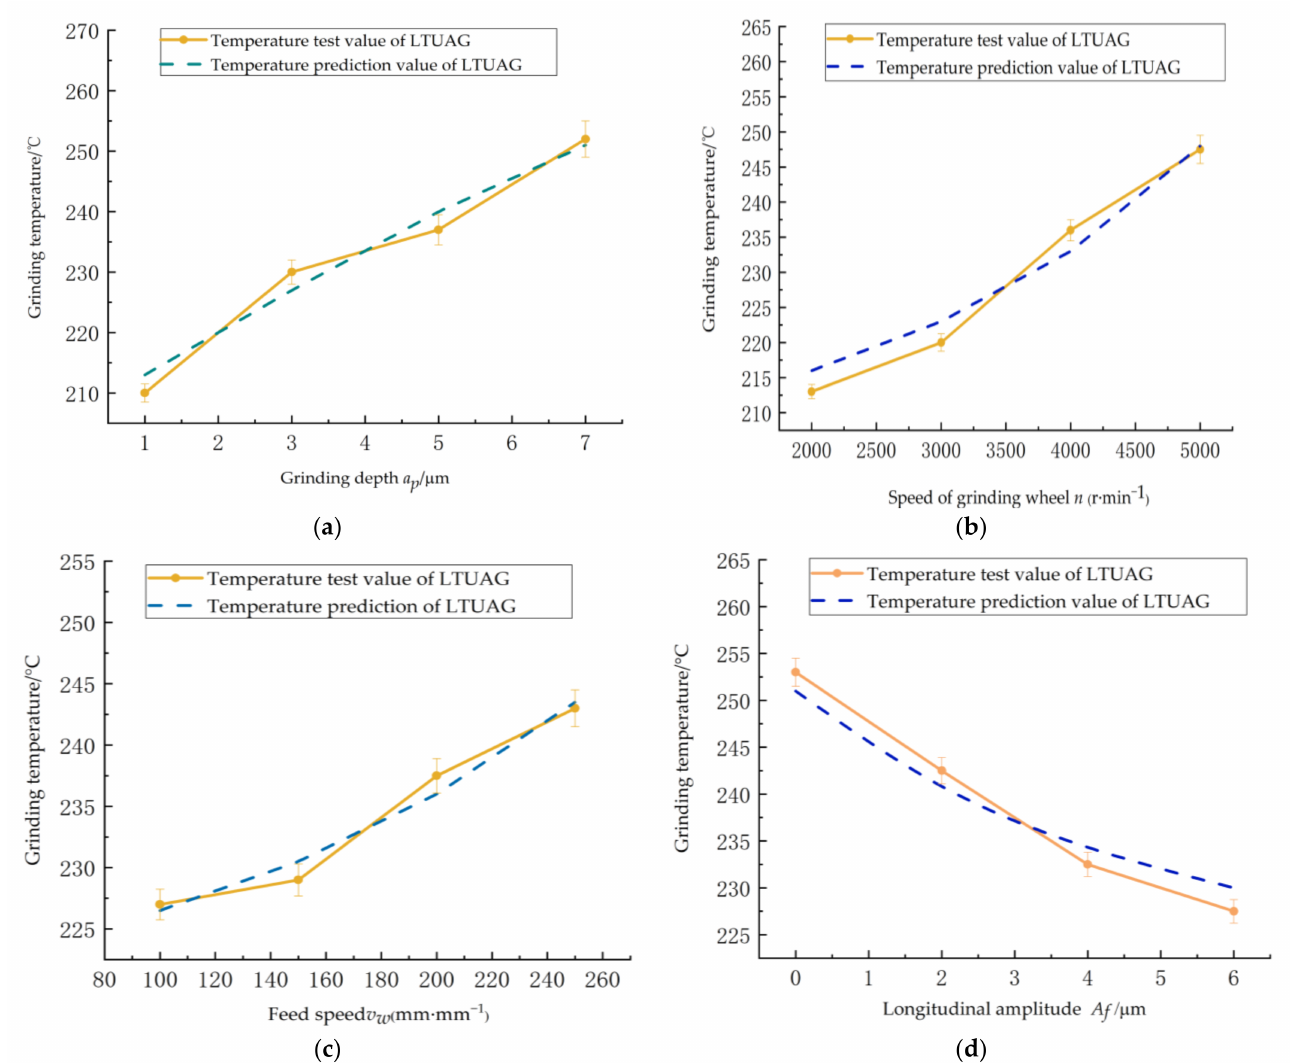
Figure 8. The influence of process parameters on the grinding temperature of LTUAG. ( a ) Depth of grinding. ( b ) Speed of the grinding wheel. ( c ) Feed rate. ( d ) Longitudinal